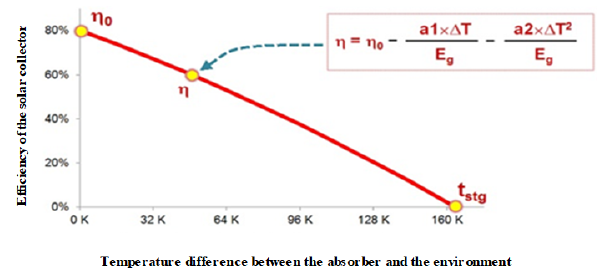
Figure 4: Eflciency of solar collectors